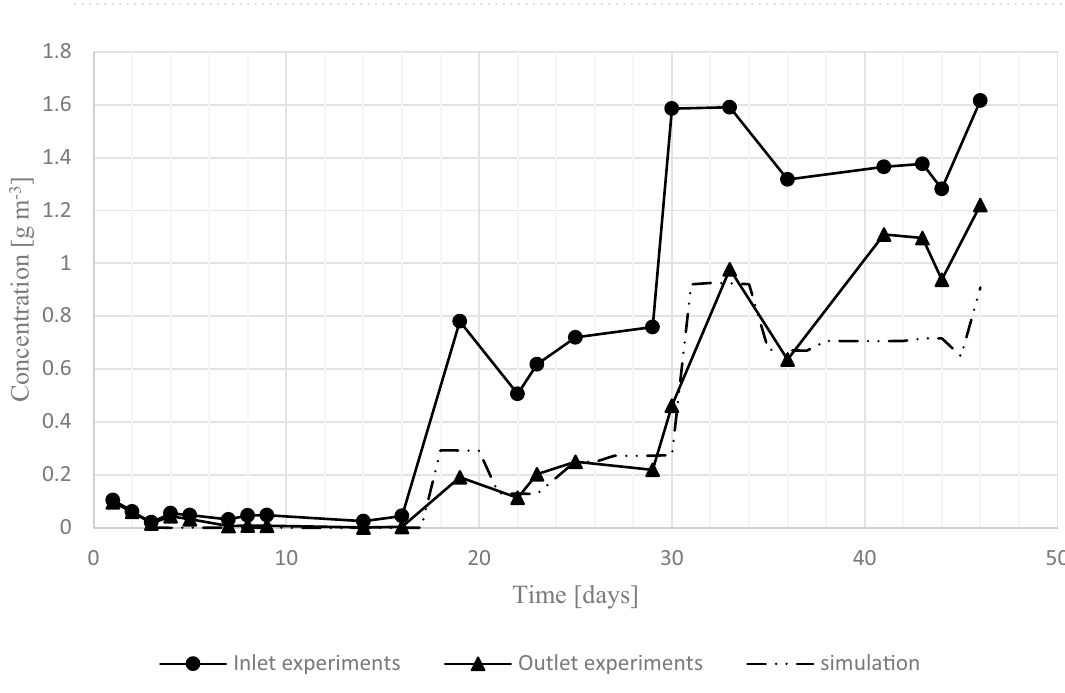
Figure 6. Experimental inlet and outlet concentration and predicted outlet